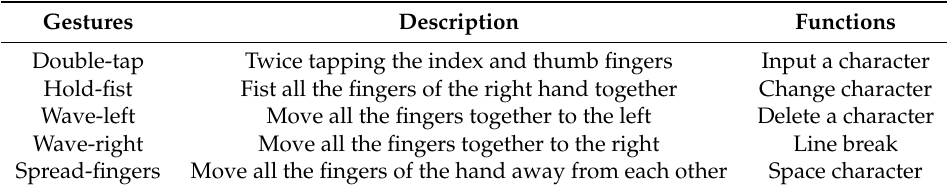
Table 3. Description of hand gesture